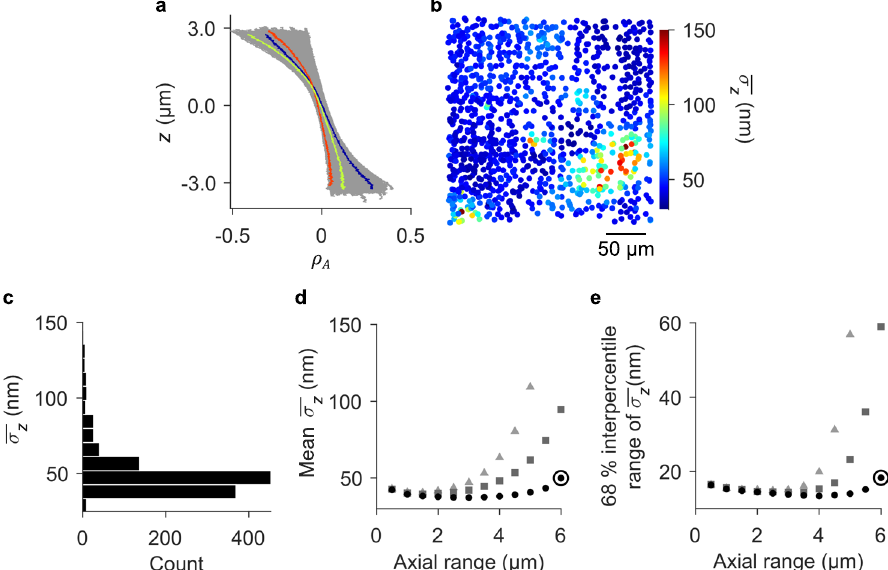
Fig. 3 Field dependence of local values of uncertainty components from axial localization. a Line plots showing the relationship z ( ρ A ) for many calibration particles. Three representative lines have colors corresponding to the map in ( b ) for local values of uncertainty (cid:2) σ z from the polynomial models { z ( ρ A )} cal . The overbar denotes the mean uncertainty over the axial range of ( a ). b Scatter plot showing the lateral positions of the calibration particles and corresponding values of (cid:2) σ z for an axial range of 6 µ m. c Histogram showing an asymmetric distribution of (cid:2) σ z for an axial range of 6 µ m. d Plot showing variation of the mean value of (cid:2) σ z for all particles as a function of axial range for (triangles) { z ( ρ )} cal , (squares) { z ( ρ w )} cal , and (circles) { z ( ρ A )} cal . e Plot showing variation of the 68 % interpercentile range of (cid:2) σ z for all particles as a function of axial range for (triangles) { z ( ρ )} cal , (squares) { z ( ρ w )} cal , and (circles) { z ( ρ A )} cal . Roundels in ( d – e ) correspond to ( a – c ). Uncertainties in ( d – e ) are smaller than the data